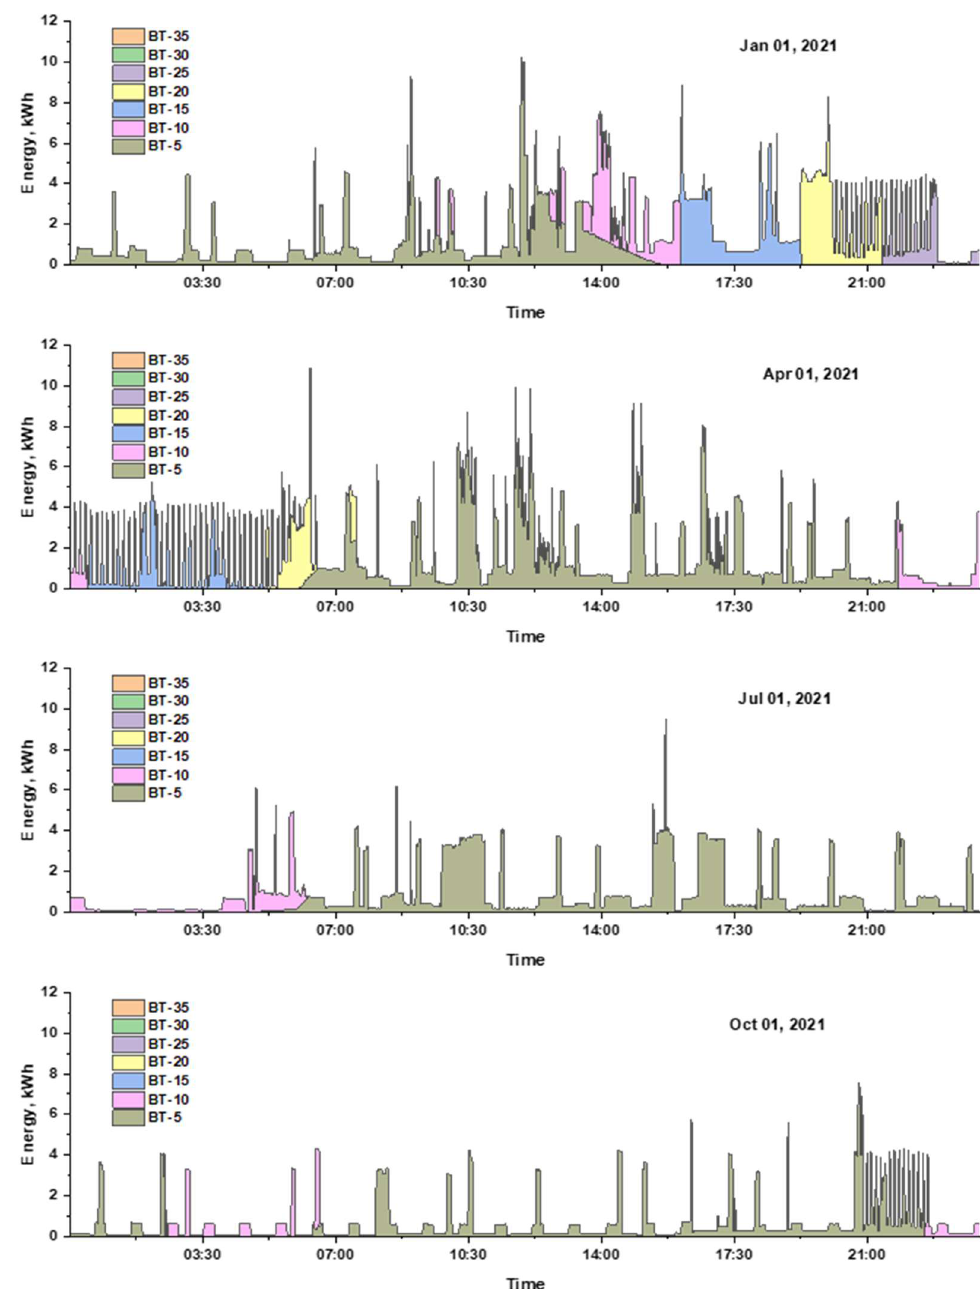
Figure 9. The E SC for various battery bank capacities for four days.